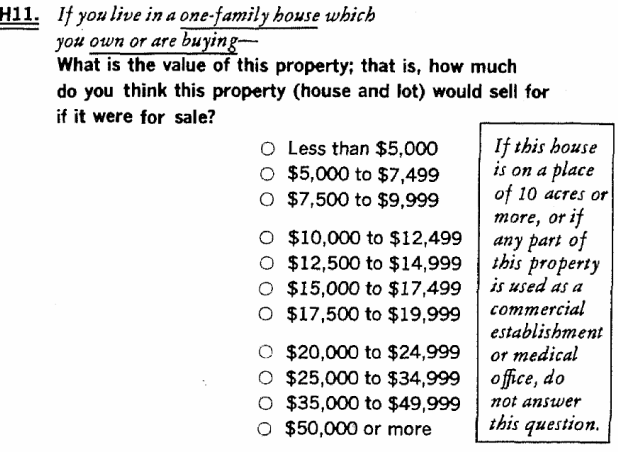
Table A.1: Five-number summary of counts of block-based housing unit counts by block for reference, and of counts of blocks and aggregated block-based housing unit counts by tract. Block housing unit counts by tract 151.00 1174.50 1610.00 2165.00 5482.00 Block counts by tract 1.00